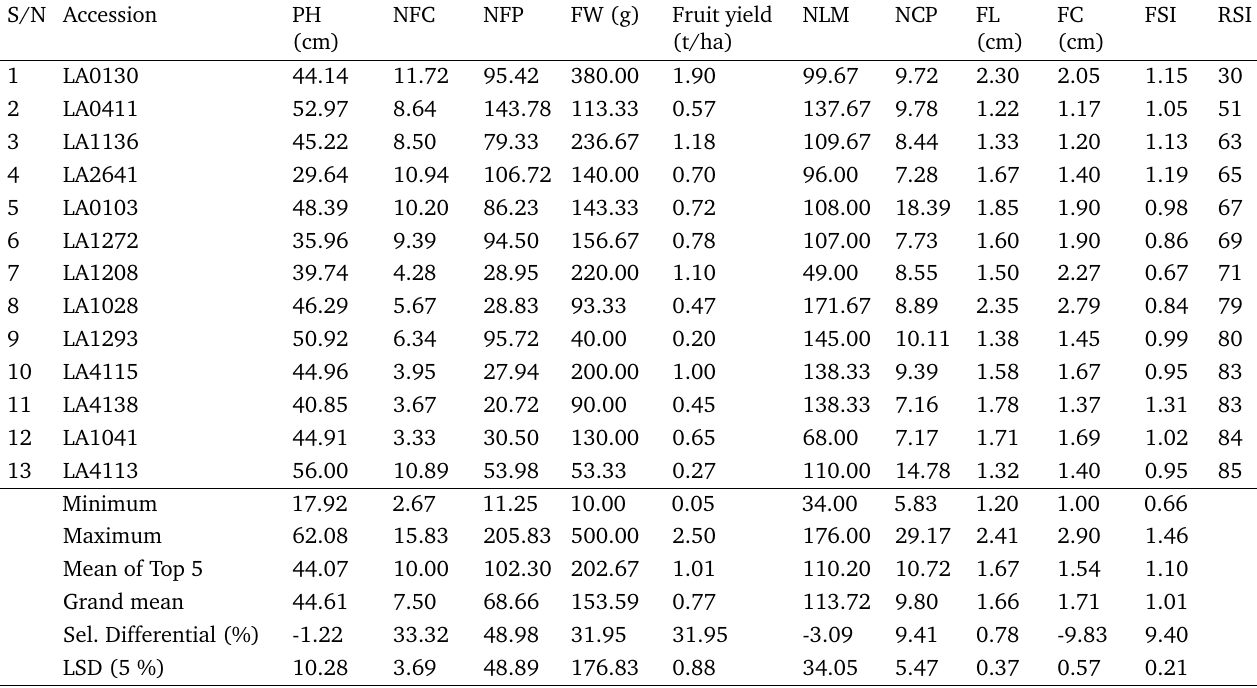
Table 3. Mean ranking of agronomic traits of wild tomato accessions evaluated under the rainforest agro-ecology zone in Nigeria